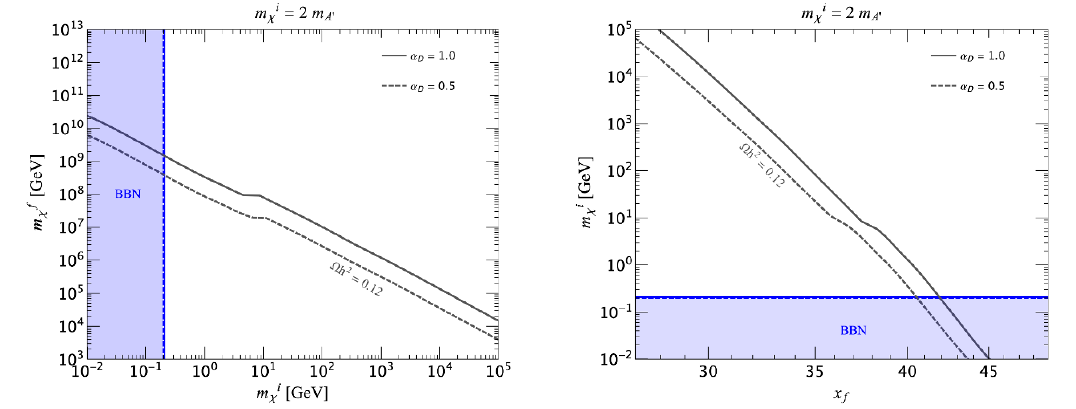
Figure 2 . Relic abundance in the m f vs. m i parameter space on the left and in the m i (cid:31) (cid:31) x f parameter space on the right. The solid diagonal line represents the thermal relic abundance corresponding to (cid:10) (cid:31) h 2 (cid:10) ob h 2 [28] assuming (cid:11) D = 1 : 0 and the dashed line is one with (cid:11) D = 0 : 5. (cid:25) The blue shaded region represents the BBN bound on this model, in which any initial dark matter mass lower than 200 MeV is excluded (see text for more (cid:24)